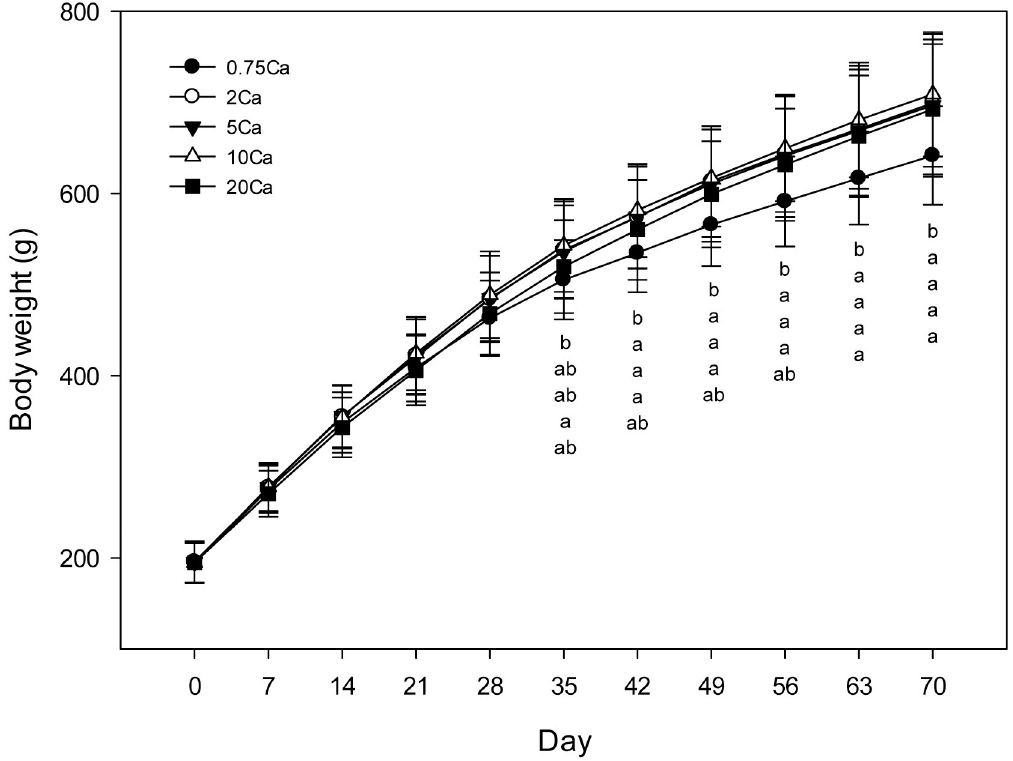
Fig 1. Body weights of rats. Results are presented as means ± SD, n = 28–30. Results were analyzed by mixed-design ANOVA to determine effects and interaction of diet and time. For time points with a significant ( p < 0.05) diet effect, differences among diet groups were determined using one-way ANOVA followed by the Holm-Sidak post-hoc test. Diet groups without a common letter differ, p < 0.05. Letters correspond to diet groups 0.75Ca, 2Ca, 5Ca, 10Ca and 20Ca sequentially from top to